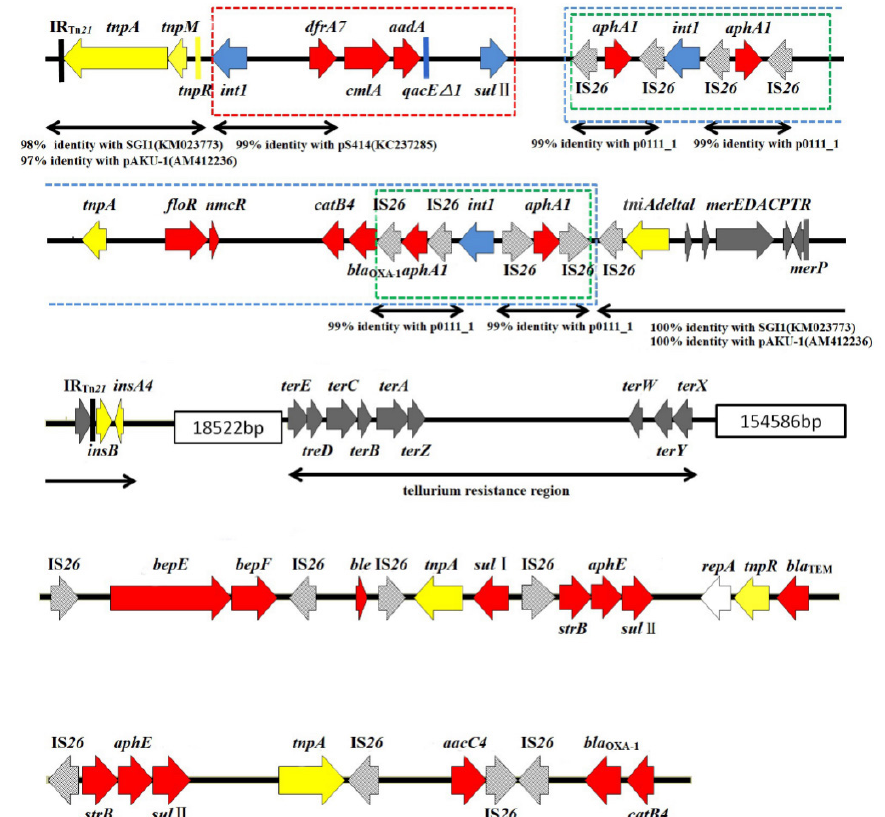
Figure 1. Schematic diagram of RR1. The red arrows in the figure represent drug-resistance gene cassettes, yellow arrows represent genes related to a transposition function, blue arrows represent the type I integrase genes and the integron-gene cassette 3' conserved region gene structures, light gray arrows represent movable IS 26 elements, dark gray arrows represent heavy-metal- and non-metal-resistance genes, the red dashed box is a type I integron structure, the green dashed boxes are assumed to be a movable element structure, and the blue dashed boxes are assumed to be compound recombination. The structure of the arrow: the direction of the arrow shows the direction of gene coding, and the size of the arrow is drawn according to the size of the coding gene and the length of the gene sequence of the RR1 region.